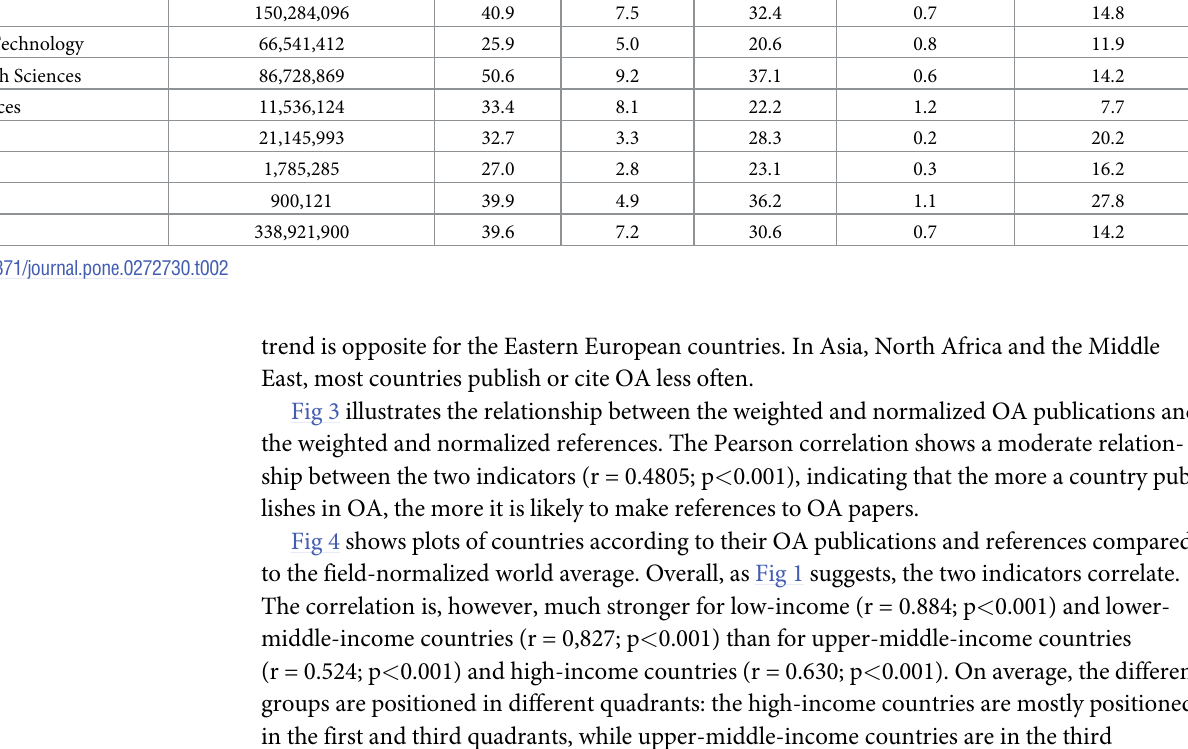
groups are positioned in different quadrants: the high-income countries are mostly positioned in the first and third quadrants, while upper-middle-income countries are in the third